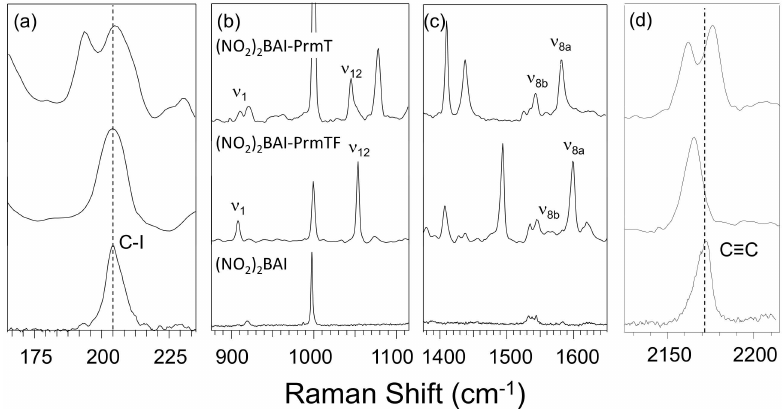
Figure 6. Experimental Raman spectra of (NO 2 ) 2 BAI (bottom), and the co-crystals formed from (NO 2 ) 2 BAI with either PrmF (middle) or PrmT (top) in di ff erent spectral